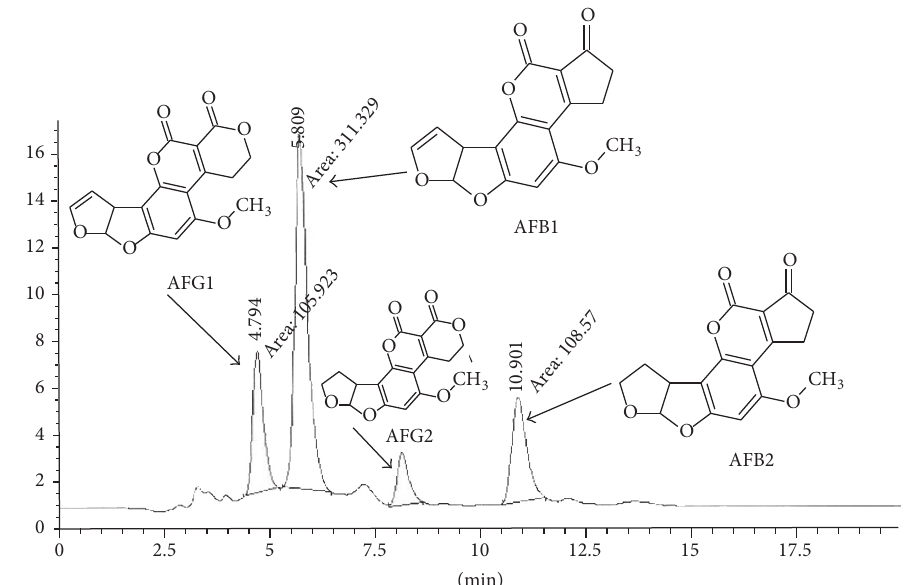
Figure 1: HPLC chromatogram of aflatoxin standards.